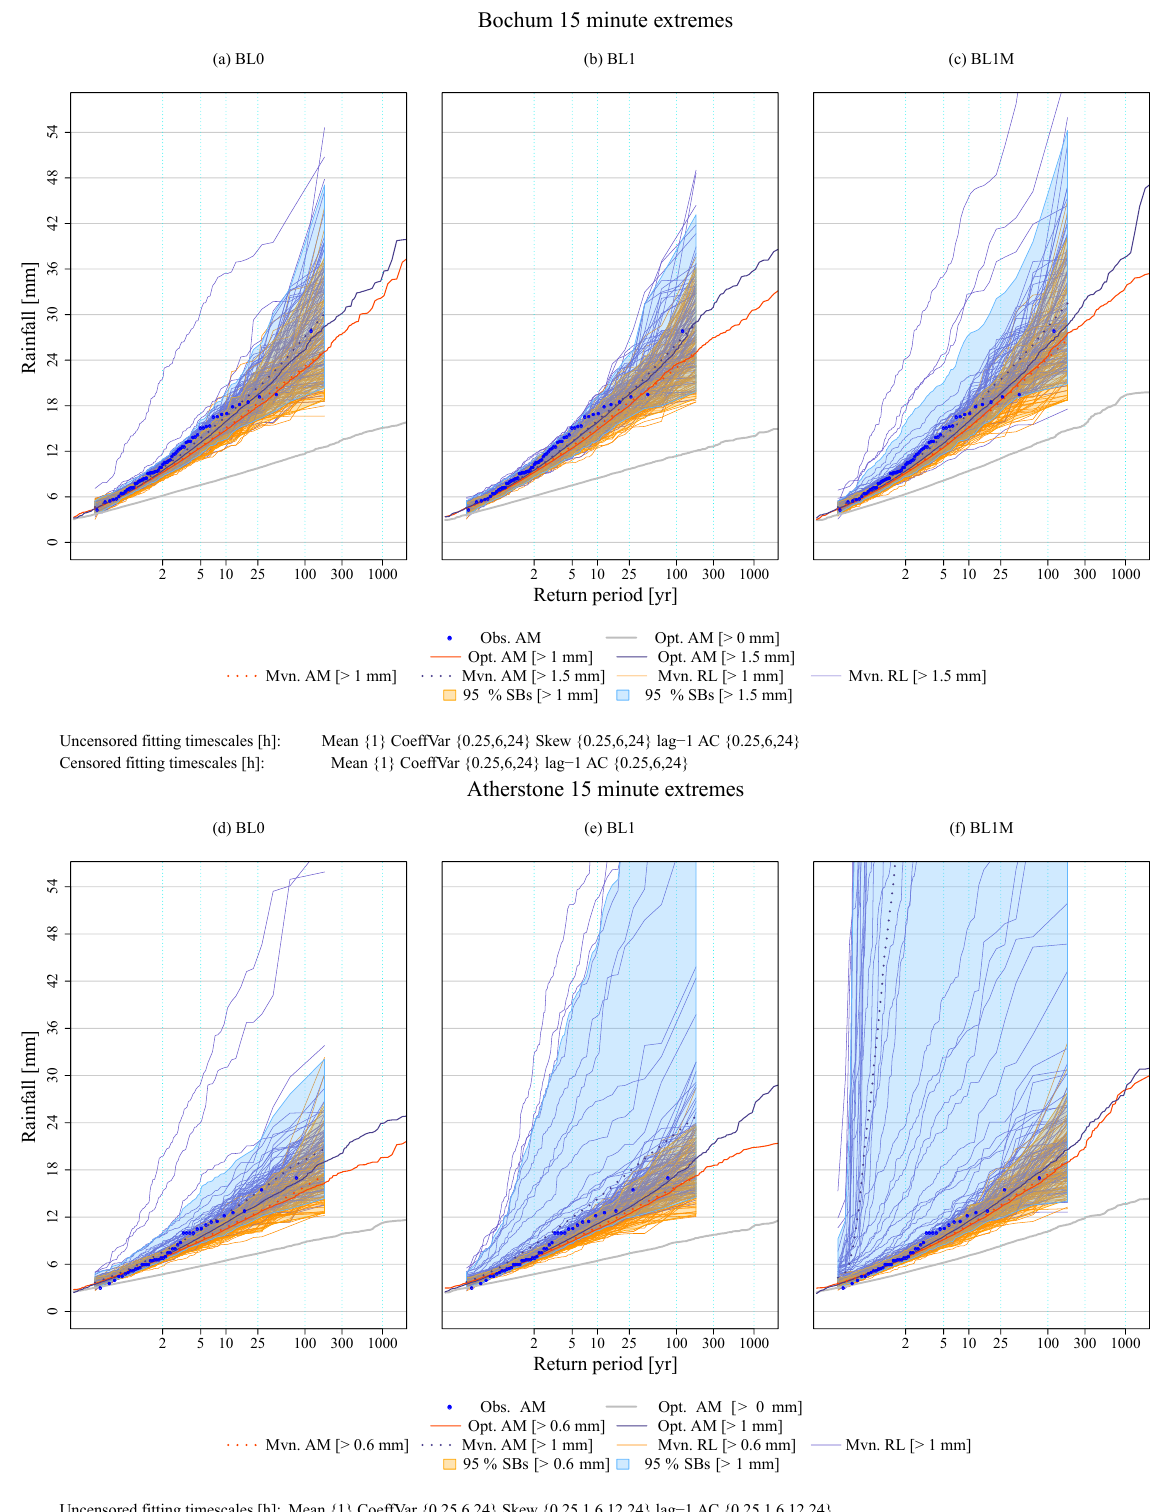
Figure 10. Change in 95% simulation bands (SBs) and means of the MVN realizations (mvn. AM) for Bochum and Atherstone 15min data with well-identified ( > 1.0 and > 0.6mm) and poorly identified ( > 1.5 and > 1.0mm) censored model parameters. The spread of the individual realizations is also shown with solid lines (mvn.